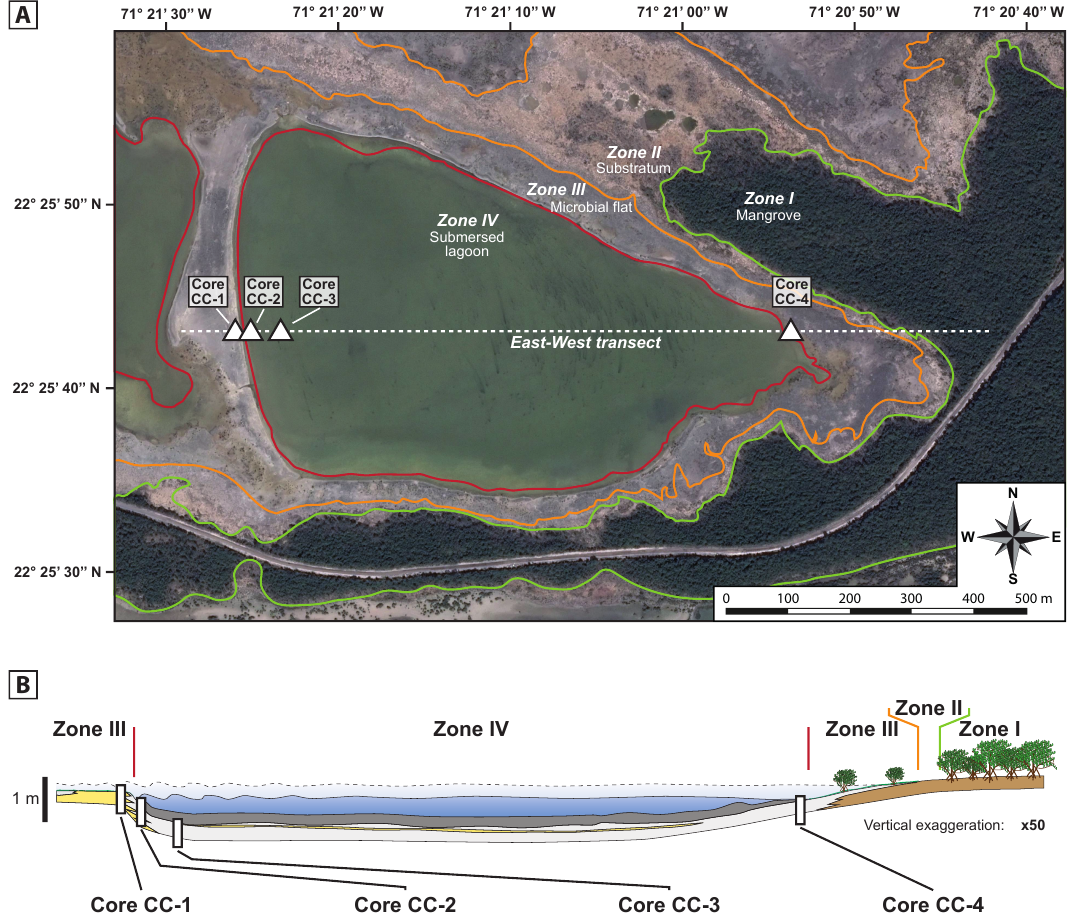
Figure 2. ( A ) Satellite images depicting the four depositional environments used in this study: Zone I—Mangrove; Zone II—Substratum area; Zone III—Microbial flat and Zone IV—Submersed lagoon (modified after [29]) and the location of the east-west transect and associated four cores used in this study. Satellite images are provided by Flash Earth (with Bing maps), © Microsoft Corporation—Imagery © Harris Corp, Earthstar Geographics LLC. ( B ) Cross section of the east-west